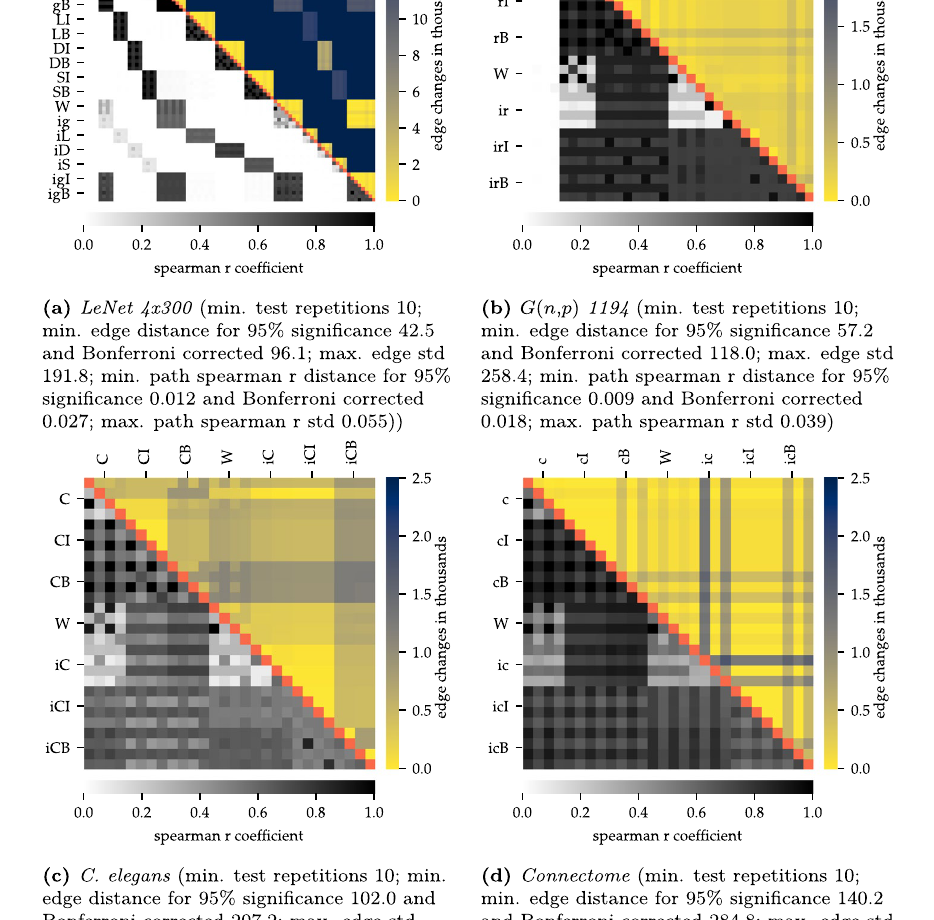
Figure 4. Toast plot type 1: Edge and weight changes during learning and between different initial states. Identical tests marked red. Each run is marked with an abbreviation at the side of the graph. Each of these include four different subvariants (each as its own pixel), entailing the initial status or the trained status after 30 epochs training for MNIST and Fashion-MNIST respectively. Toast plot ( a ) shows the LeNet 4x300 , ( b ) G(n,p) 1194 , ( c ) C. elegans 26 and ( d ) the human connectome 27 . In all four networks broad yellow regions indicate very few changes in the edges between different initalization settings. Widespread black or dark grey regions in the lower left toasts exhibit convergence in its active weights. This effect is much more conserved in the recurrent networks, but also the feed-forward networks show this effect blockwise within one initalization method. The minimum distances for a 95% significance are based on t-test. R—reference, g—Glorot, L—lightning , D—dense diversity, S—sparse diversity initialization; c—connectome, C— C. elegans ; I—iterative pruning, B—bio pruning; W—winning ticket, i—structure